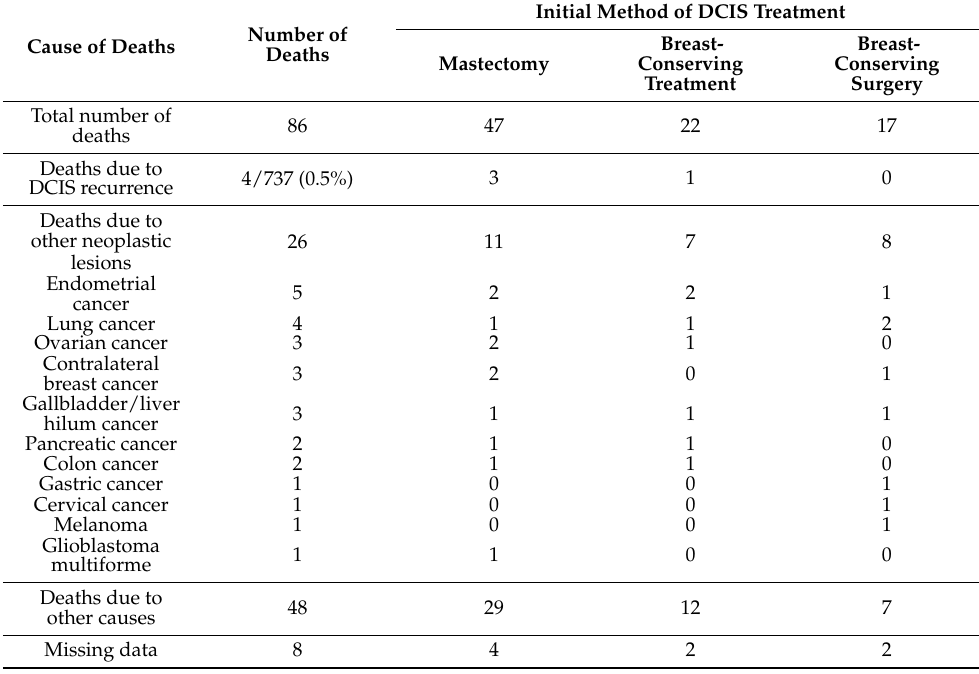
Table 4. Causes of 86 deaths among 737 patients with DCIS, with subdivision according to the initial method of treatment of